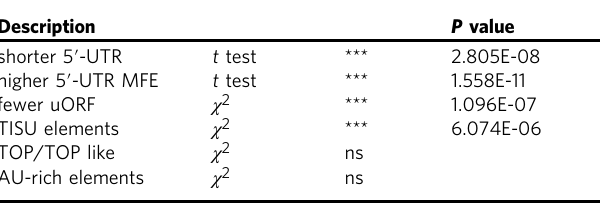
Table 2 Structural features of the mRNAs that are most